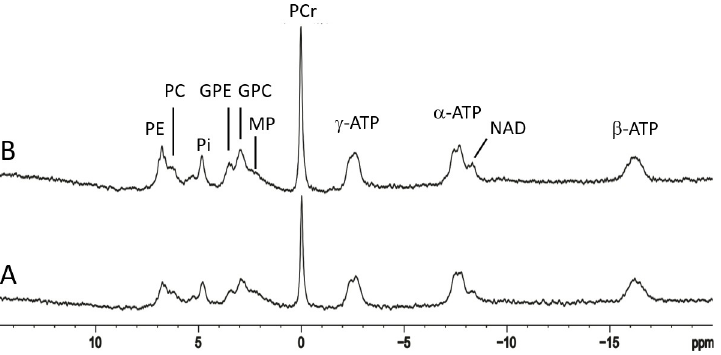
Fig 4. Typical 3 Tesla 31 P spectra of a healthy volunteer. A 3 Tesla spectrum at (A) TR = 2.5 seconds, NA = 128 and (B) TR = 25 seconds, NA = 128. PE: phosphoethanolamine; PC: phosphocholine; Pi: inorganic phosphate; GPE: glycerophosphoethanolamine; GPC: glycerophosphocholine; MP: membrane phospholipids; PCr: phosphocreatine; α -, β -, γ -ATP: α -, β -, γ -adenosine triphosphate; NAD: nicotinamide adenine